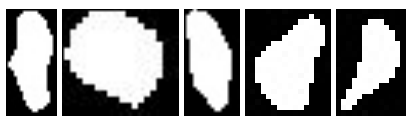
Figure 12. Termite mound templates for the shape matching